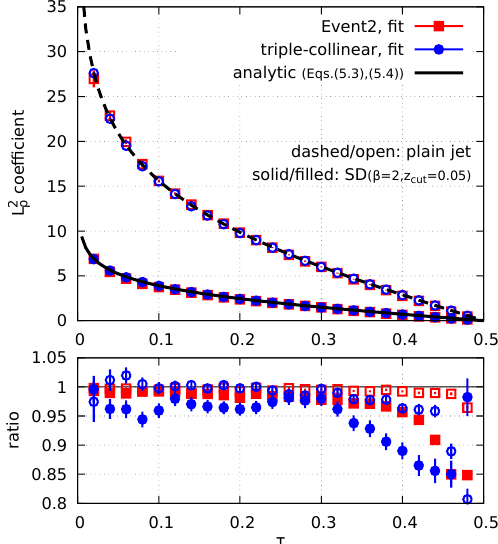
Figure 5 . Coe(cid:14)cient of the log 2 (1 =(cid:26) ) contribution to the H ( (cid:26); > (cid:28) ) distribution. For the Event2 results ((cid:12)lled symbols) and the results obtained by integrating over the triple-collinear splitting function (open symbols), we perform a (cid:12)t to the numerical results for each value of (cid:28) . (Red) circles correspond to results obtained from the plain jet, and (black) squares to results where SoftDrop has (cid:12)rst been applied. The plot insert shows the ratio to the expected analytic result.